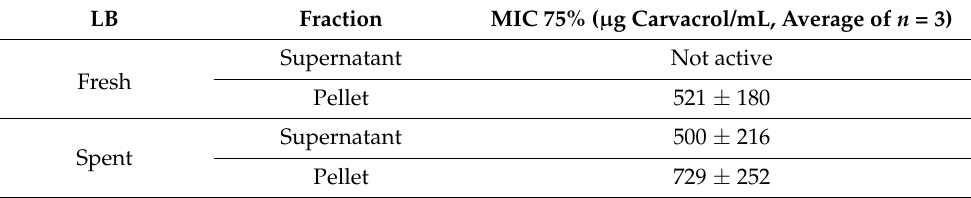
Table 3. In vitro antibacterial activity on E. coli of YP pro-carvacrol sample before and after incubation in LB spent media.